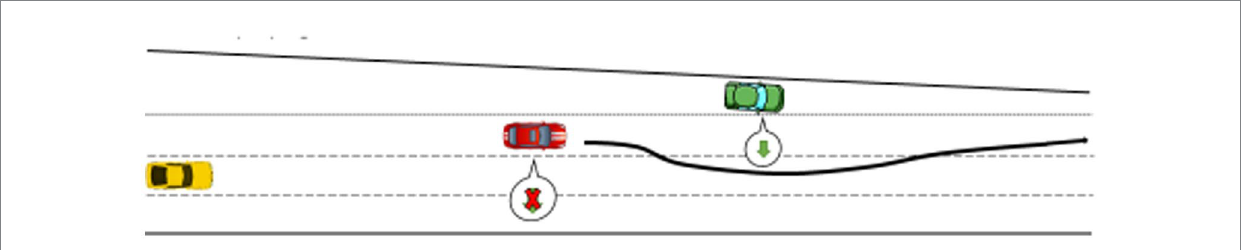
FIGURE 5 Silent failure condition: the ego vehicle gives way to the green vehicle merging-in and then overtakes it despite the turn signals fail to activate.